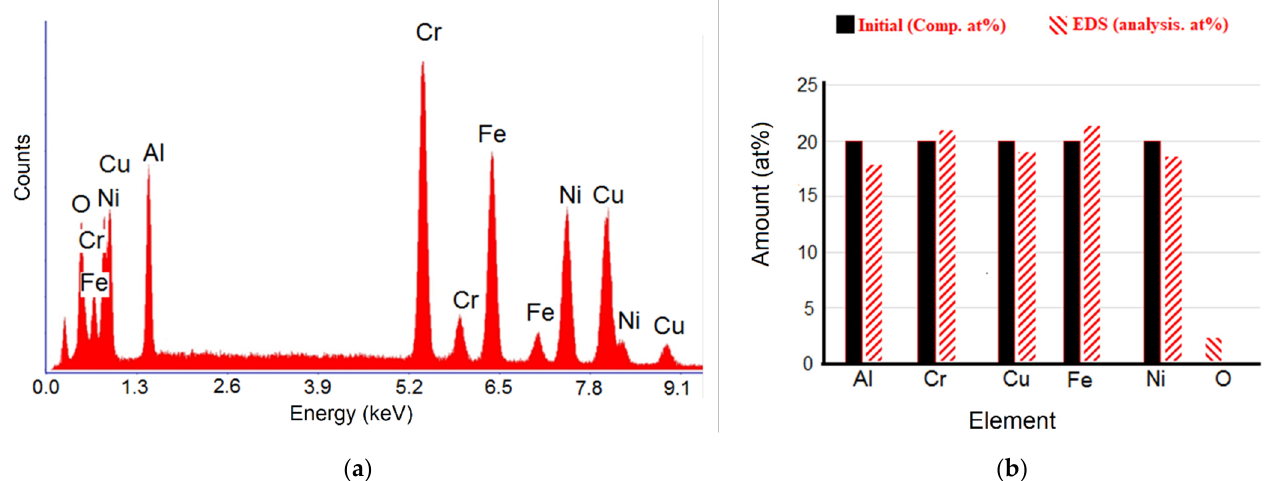
Figure 7. The EDS spectrum ( a ) and quantitative analysis ( b ) of AlCrCuFeNi alloy after 60 h of milling. Metals 2021 , 11 , x FOR PEER REVIEW